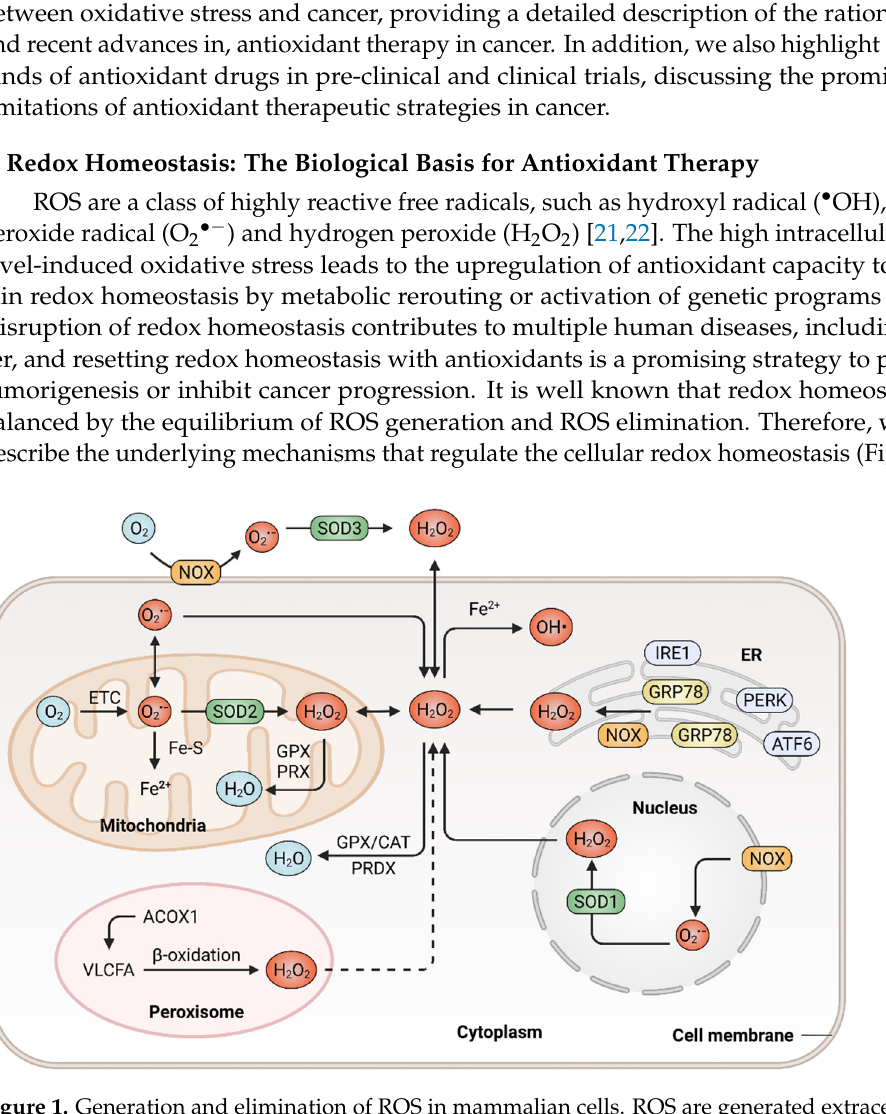
Figure 1. Generation and elimination of ROS in mammalian cells. ROS are generated extracellu- larly by NADPH oxidase (NOX) or intracellularly in different subcellular compartments, includ- ing endoplasmic reticulum (ER), peroxisome, nucleus as well as the mitochondrial electron transport chain (ETC). Antioxidant systems include the peroxiredoxin (PRDX), the glutathione peroxidase (GPX) and catalase (CAT) in the cytosol or mitochondria, which hydrolyze H 2 O 2 to H 2 O.